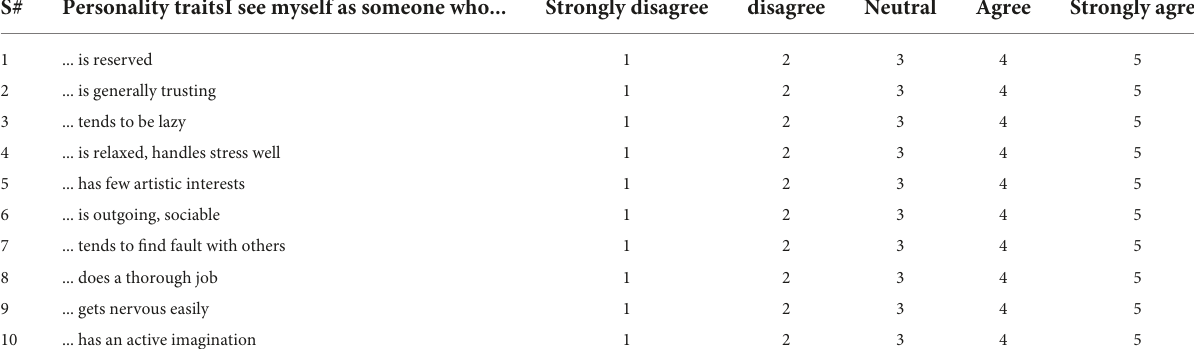
S# Personality traitsI see myself as someone who... Strongly disagree